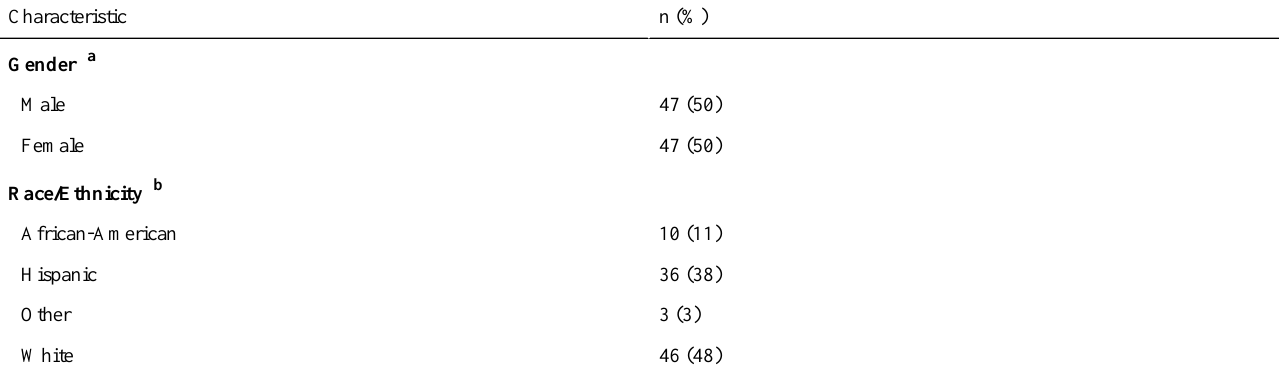
Table 2. Characteristics of the content development focus group participants (N = 95 participants in 18 focus